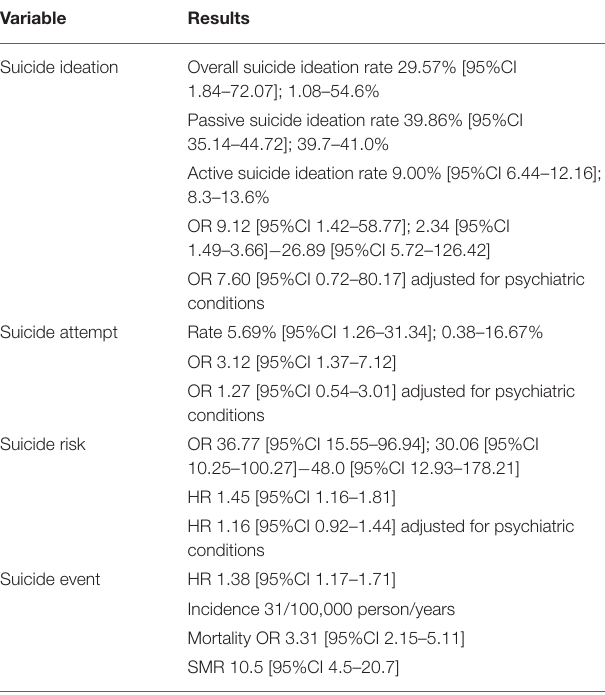
TABLE 3 | The main findings of the systematic review and meta-analysis on suicidality among fibromyalgia patients.